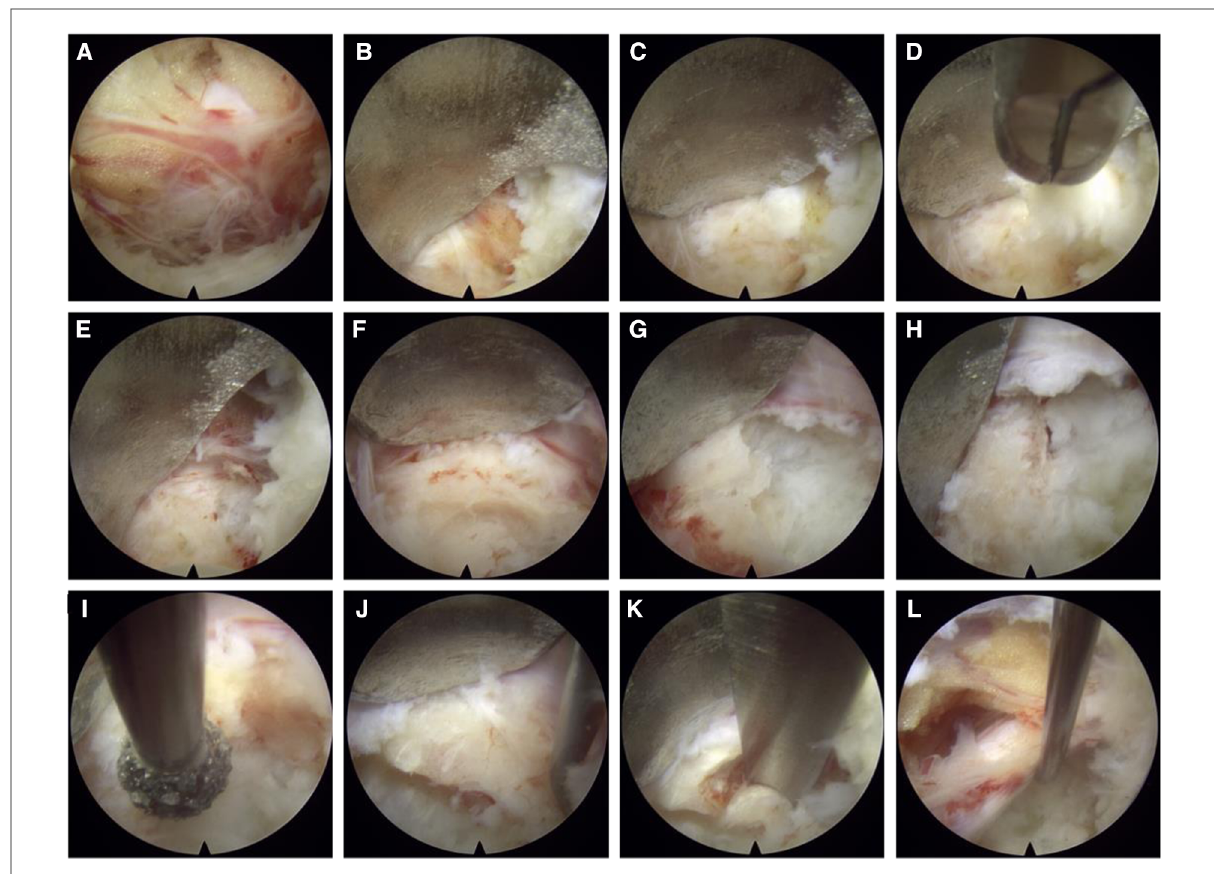
FIGURE 3 Imaging during surgical procedures: ( A ) exposure of nerve roots; ( B ) the nerve root is shown to be dissected, and the bone behind it and the protruding fi brous annulus are exposed; ( C,D ) annulus fi brosus and nucleus pulposus are shown to be removed with luminal forceps; ( E – K ) after the annulus fi brosis is shown to be removed, and the bone is also shown to be removed using trephine, grinding drill, and endoscopic bone knife; ( I ) nerve root relaxation is shown after decompression.